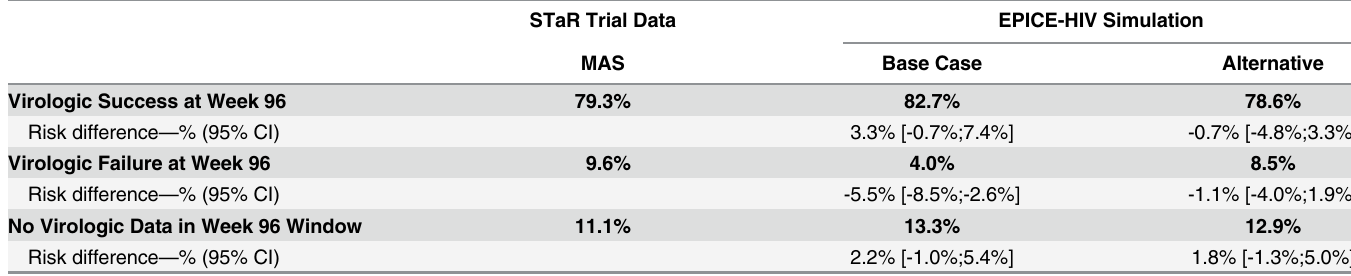
Table 9. Week 96 snapshot analysis for the RPV/FTC/TDF arm of the STaR study [33] and the simulated population in the EPICE-HIV model: risk differences between simulated and observed results.